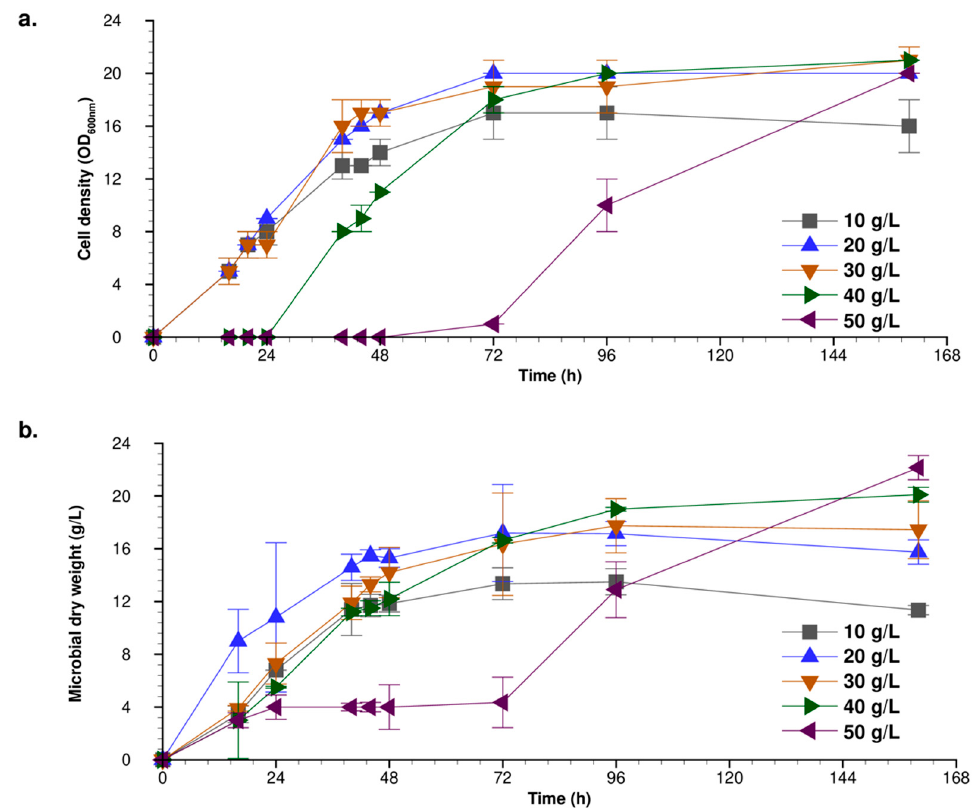
Figure 2. Growth kinetics of Y. lipolytica for different sucrose concentrations in sugar beet molasses. ( a ) Kinetics using cell density (OD 600nm ), ( b ) kinetics using microbial dry weight (g/L).